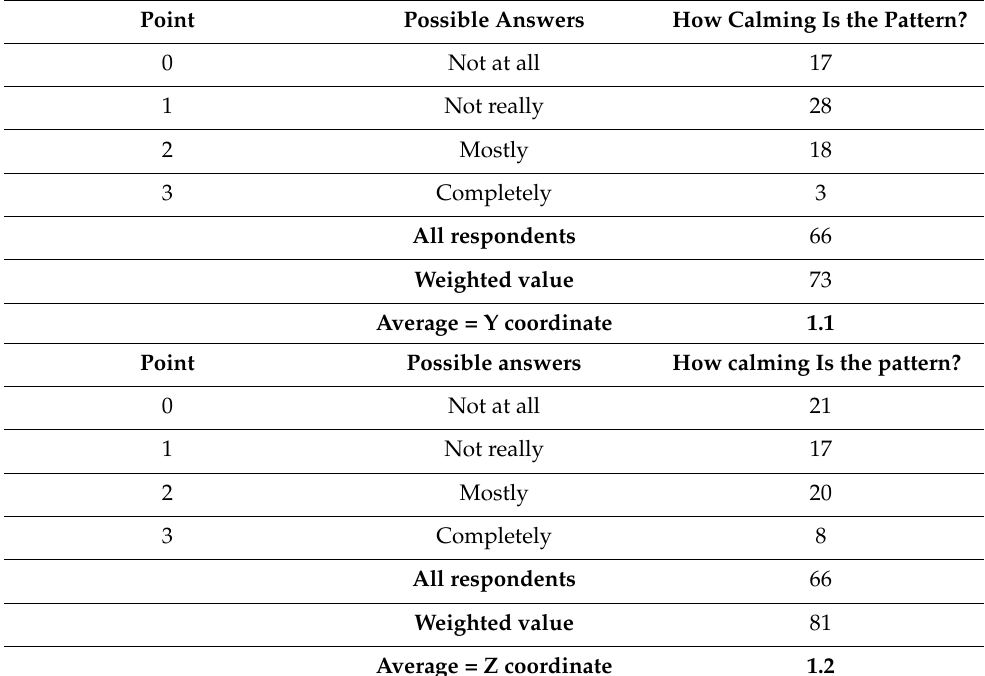
Table 4. Specify a node (first pattern—first question—y and z